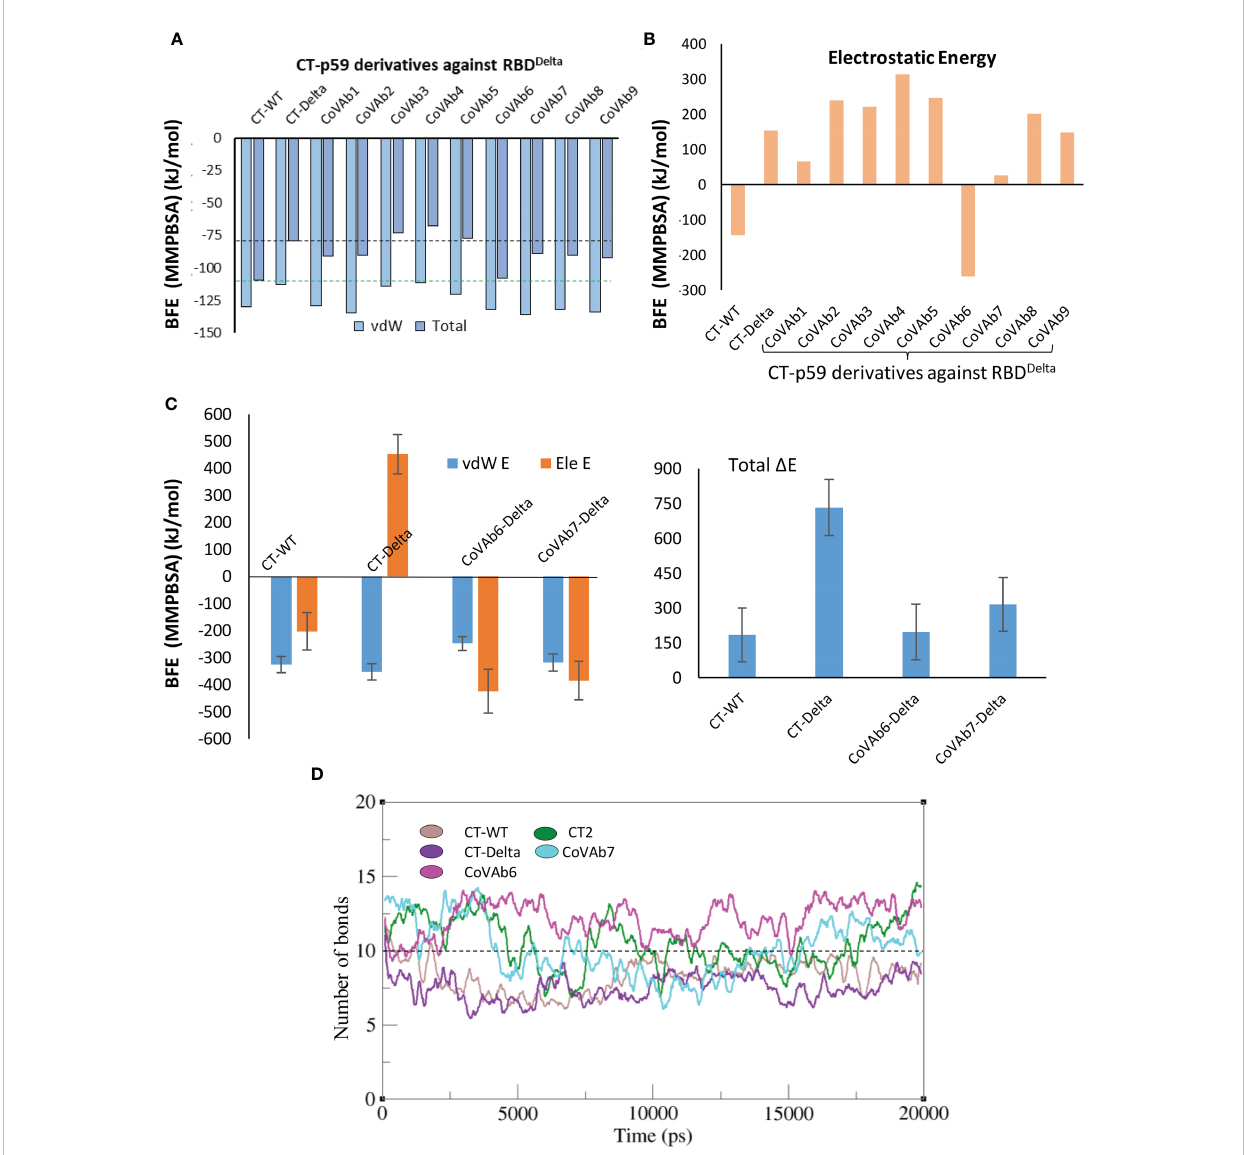
FIGURE 4 Binding free energy perturbation of the CDRs-diversi fi ed mAb (CT-p59) against Delta variant. (A) Relative changes in the total binding free energy of the CT-p59 derivatives (CoVAb1-9) are calculated through the MMGBSA method. (B) Relative change in the electrostatic energy (Ele) of the CT-p59 derivatives (CoVAb1-9). CoVAb6 fully and CoVAb7 partially restore their Ele potential that was lost by CT-p59 against the Delta variant (CT-Delta). (C) Binding free energy perturbation (MMPBSA method) of the top hits from CDR-diversi fi ed mAbs. (D) Change in the number of hydrogen bonds at the RBD-mAbs interface. The lowest number of bonds was recorded in CT-Delta. (CT-Delta=CT-p59-RBD Delta ). CoVAbs are CDR-diversi fi ed CT-p59 derived mAbs against the Delta